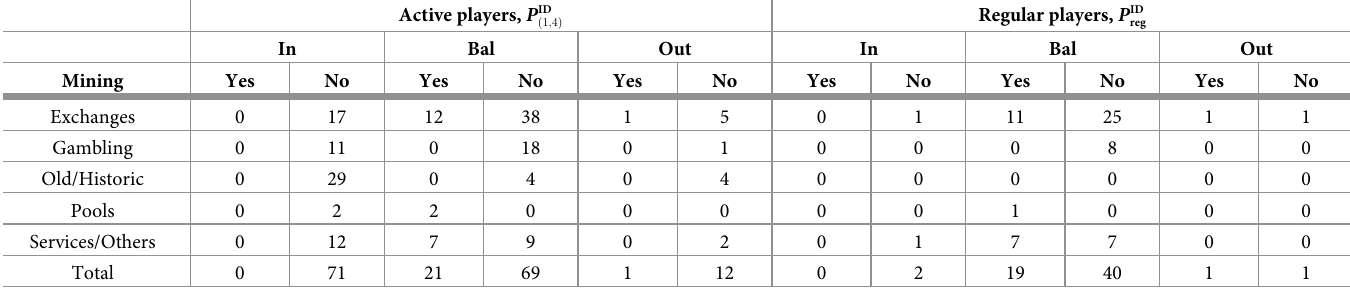
Table 4. Category of identified active and regular players appeared in the first four-week period from July 2 to July 29, 2017. “Mining” is “Yes” if a player mined Bit- coins during the target period, and ‘’No” otherwise.